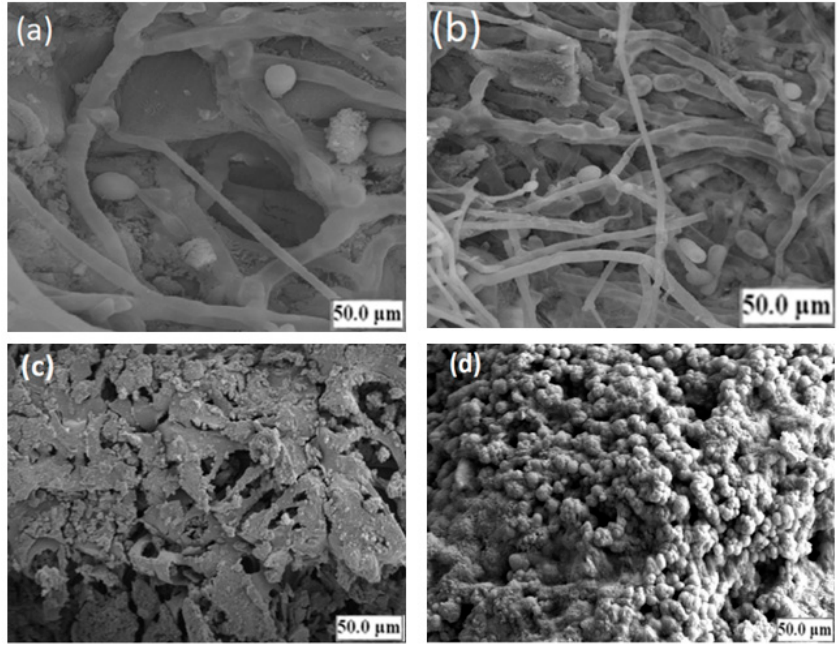
Figure 10. Represent the morphologies of inoculum in the R1 reactor ( a ) and the R2 reactor ( b ) after acclimatization ( c , d ) after contact with CSWW, ( a , b ) showing Methanosaeta sp. like morphology and ( c , d ) depicts Methanosarcina sp. like morphology.